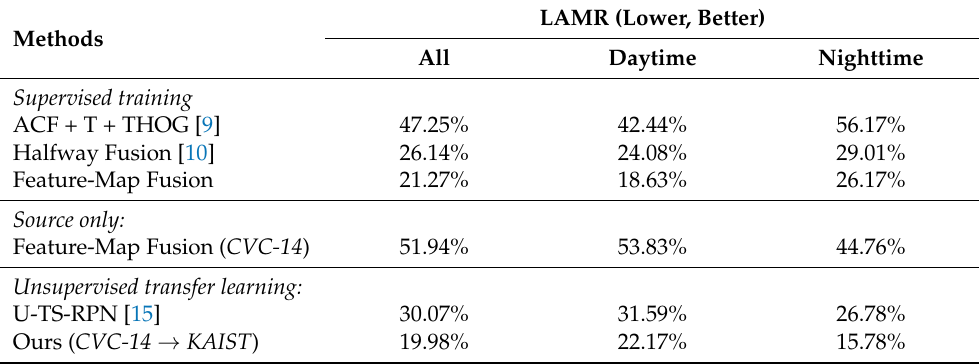
Table 1. Detection performance comparisons on KAIST dataset. The original manual annotations are used to perform the supervised training. For the results of U-TS-RPN [15], the pseudo train- ing labels are provided by the original authors and detections are generated by the fine-tuned detector accordingly.